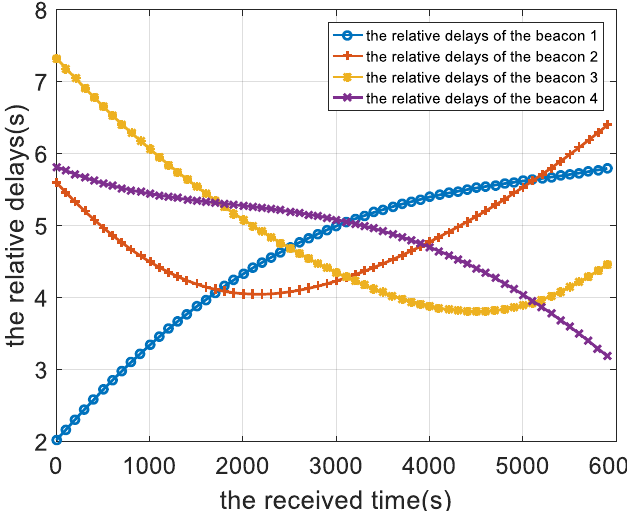
Figure 7. The positioning error analysis result of buoy 1.